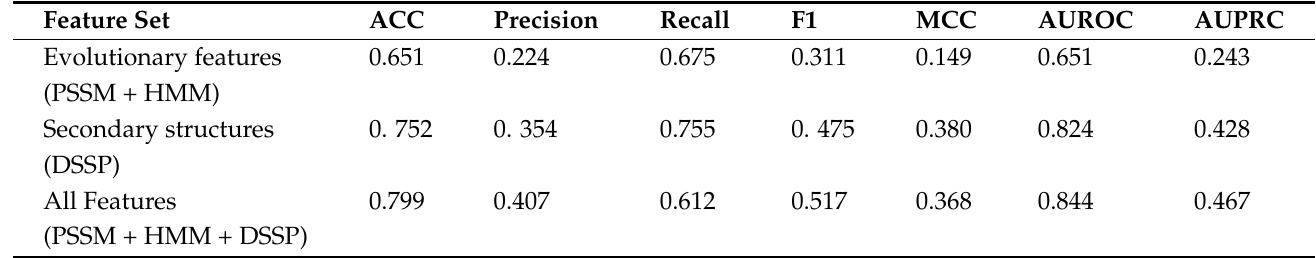
Table 2. Comparison for the individual effect of features on the proposed model (ProB-site).